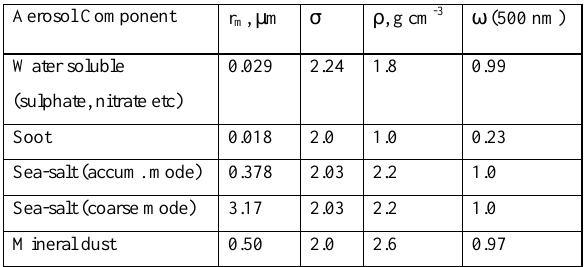
Table 1. Properties of various aerosol components. Table-1. Properties of Various Aerosol Components Aerosol Component